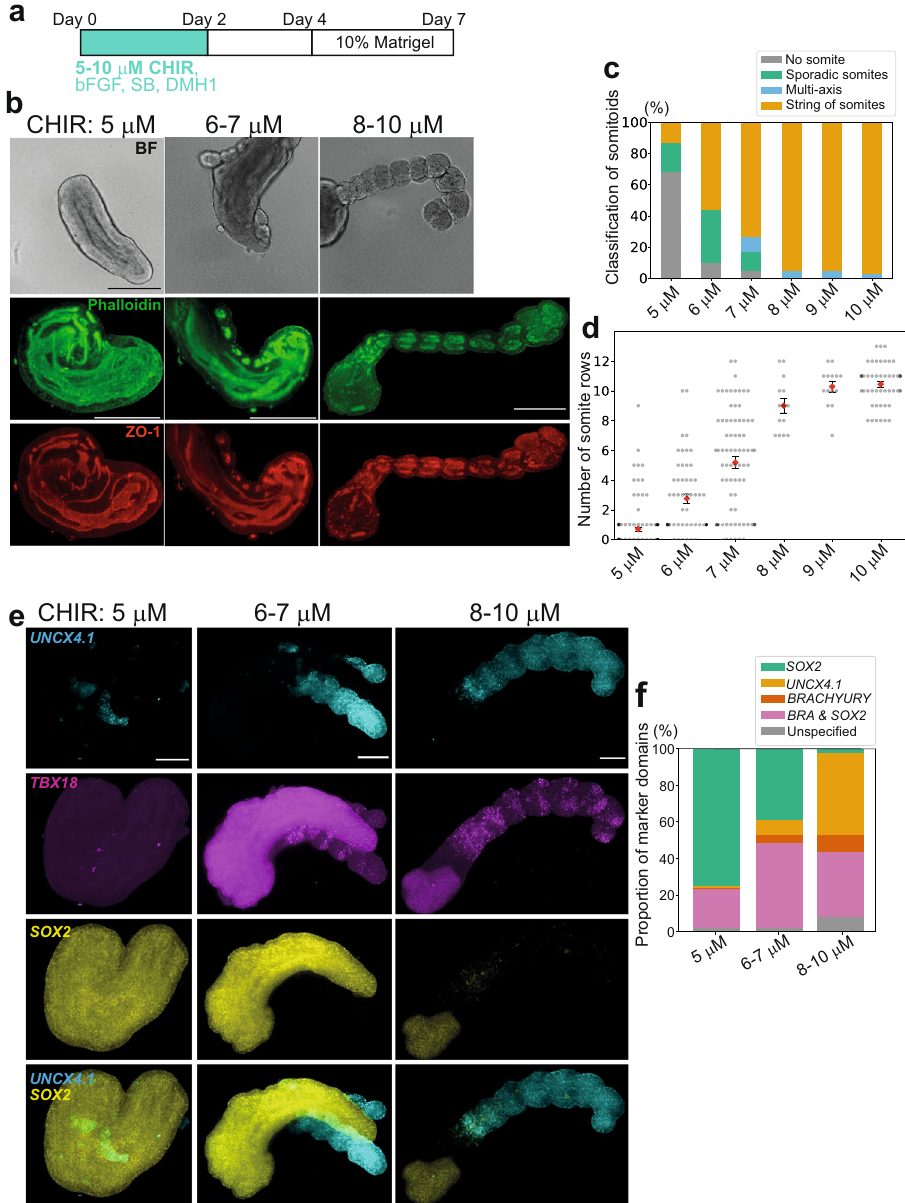
Fig. 5 WNT signaling instructs the mesodermal lineage speci fi cation. a Somitoid protocol with altered CHIR concentrations during the initial 2 days.